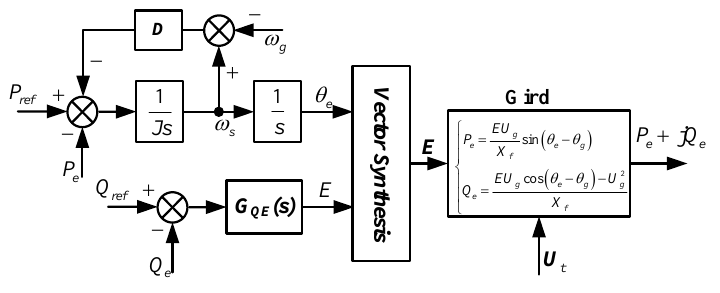
Figure 8. Typical virtual synchronous control.